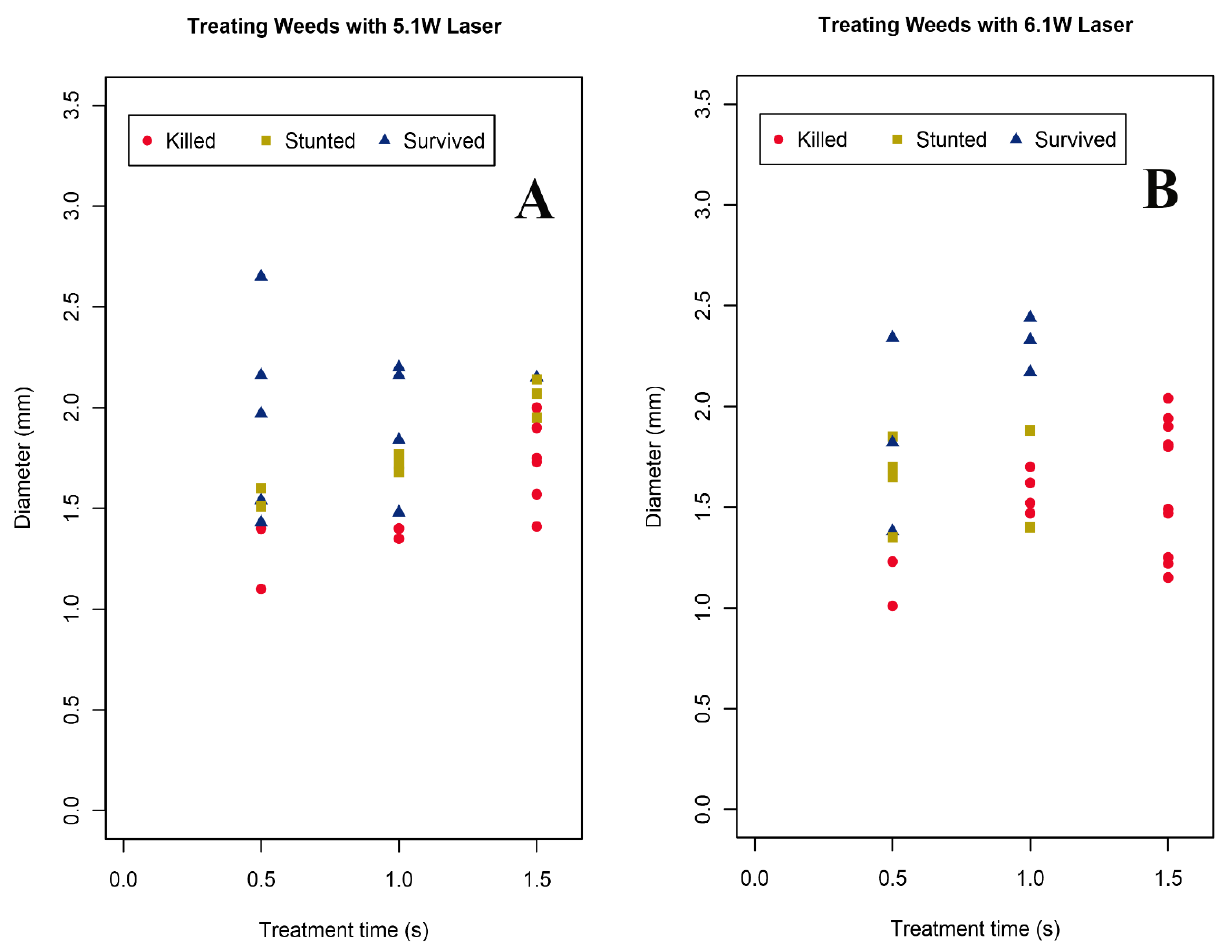
Figure 9. Status of weeds after 1 week of monitoring. ( A ) using 5.1 W laser, ( B ) using 6.1 W laser. Table 3. Percentage of weeds killed or stunted after 1 week.